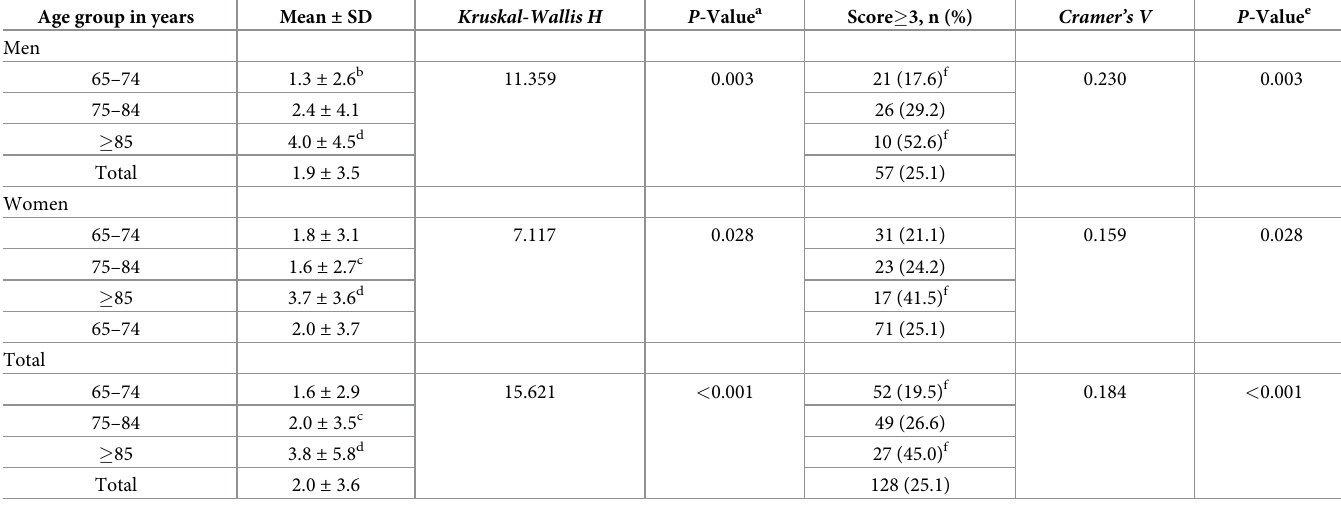
Table 4. Eating Assessment Tool (EAT-10) scores in independent older